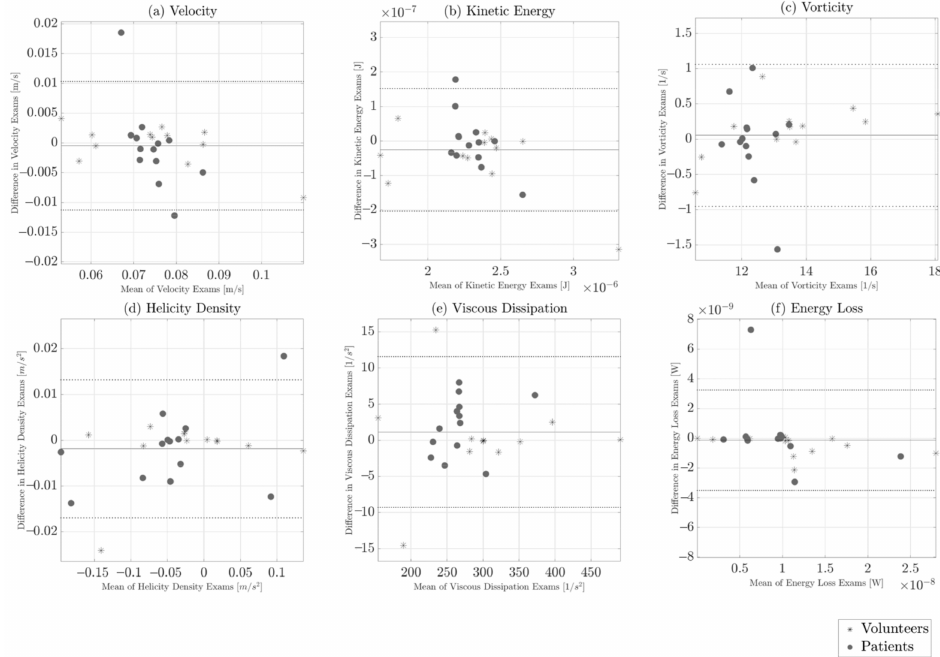
Figure A6. Bland-Altman plots represent the inter-observer reproducibility in the exams of LV global hemodynamic parameters ( a – f ) at end-diastole. The thick line represents the mean difference, and the thin lines represent the limits agreement (1.96